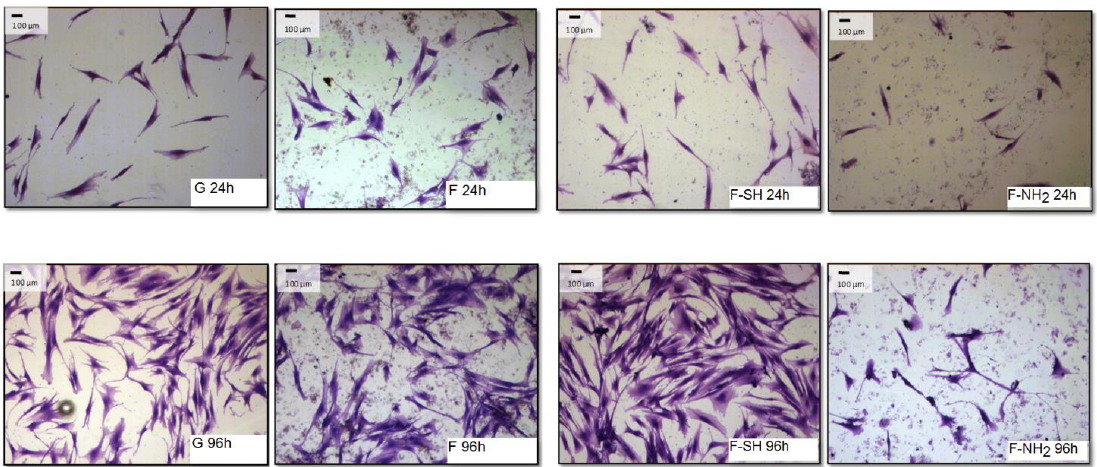
Figure 9. Paraformaldehyde (PFA) fixed and Coomassie Blue-stained NHDF cells grown for 24 and 96 h on the different substrates.